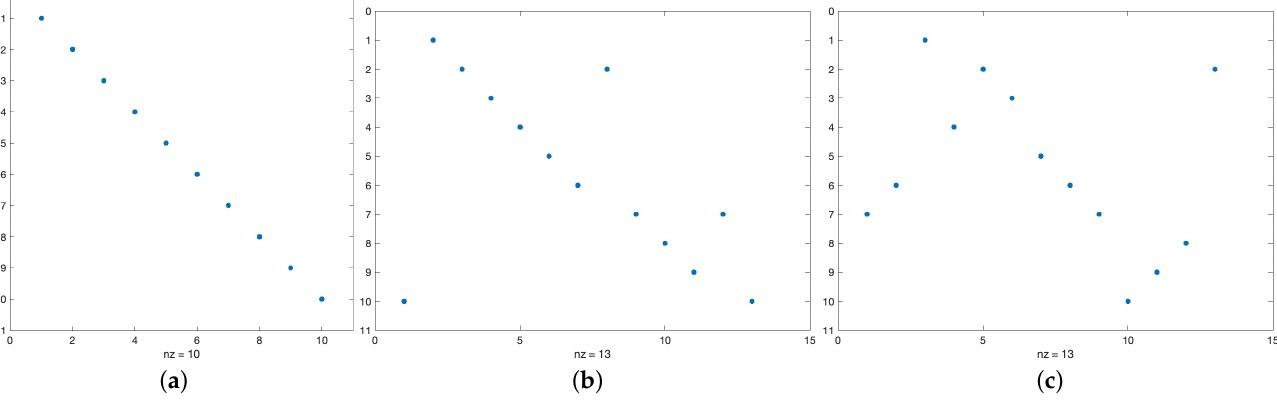
Figure 3. Dot-plots for the toy-sequences: ( a ) T = 1A2B3C4D5E; ( b ) T = E1!A2B3CA4D54E and ( c ) T =